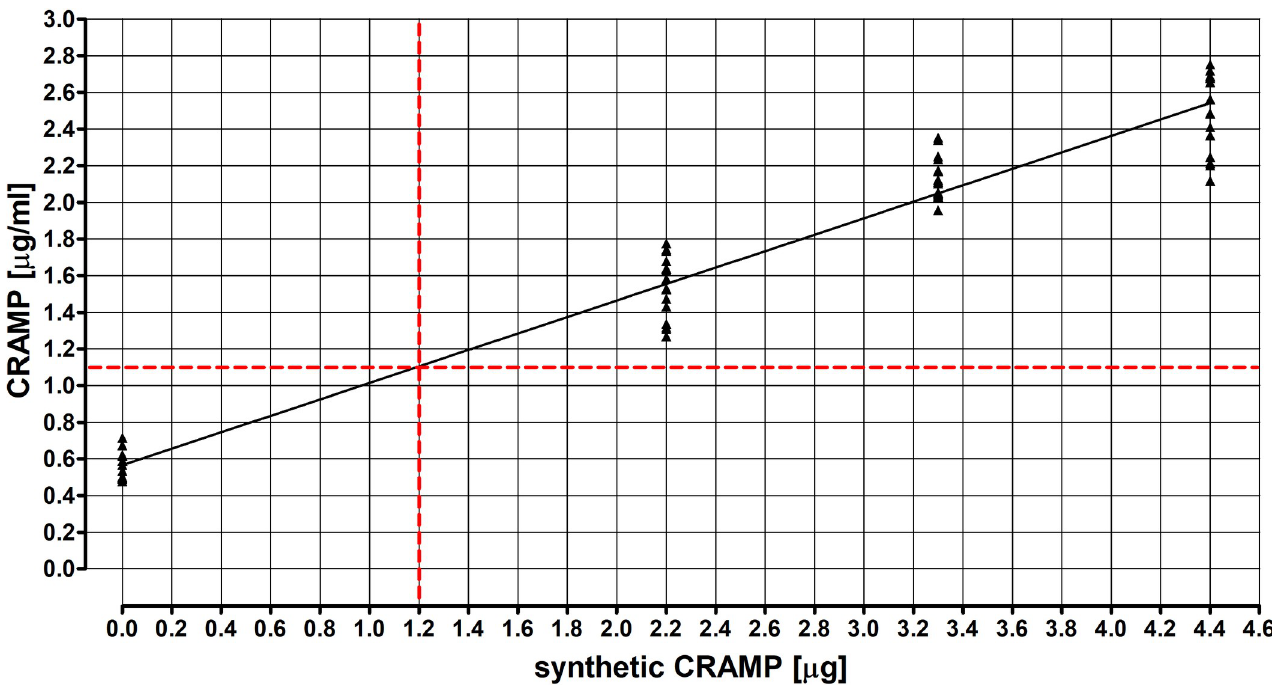
Fig 1. Relationship between lung tissue concentration of CRAMP and dose of synthetic cathelicidin use for inhalation. Protein concentration was investigated in homogenates of mouse lungs collected from untreated mice and from animals after a single exposure to synthetic cathelicidin at concentration 4, 6 or 8 times higher than physiological. Each single inhalation included 1 h exposure to PBS and 1 h exposure to appropriate concentration of synthetic cathelicidin. CRAMP concentration was determined using the ELISA method. Linear regression analysis of CRAMP concentration in response to synthetic cathelicidin inhalation was conducted. Studies were conducted in 4 research groups, each of which contained 4 animals. Each sample was analyzed in 4 replications. (control mice N = 4; treated mice per research group N = 4).